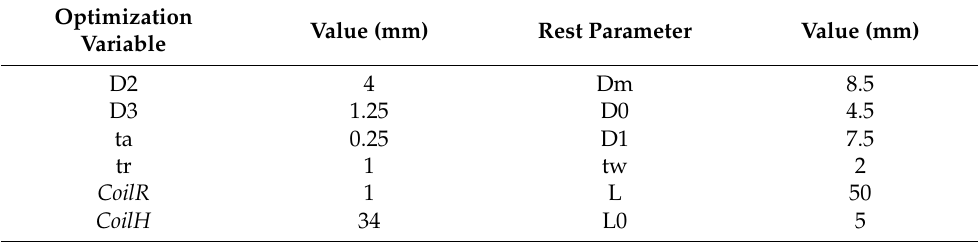
Table 3. Main structure parameters of the buffer after optimization.